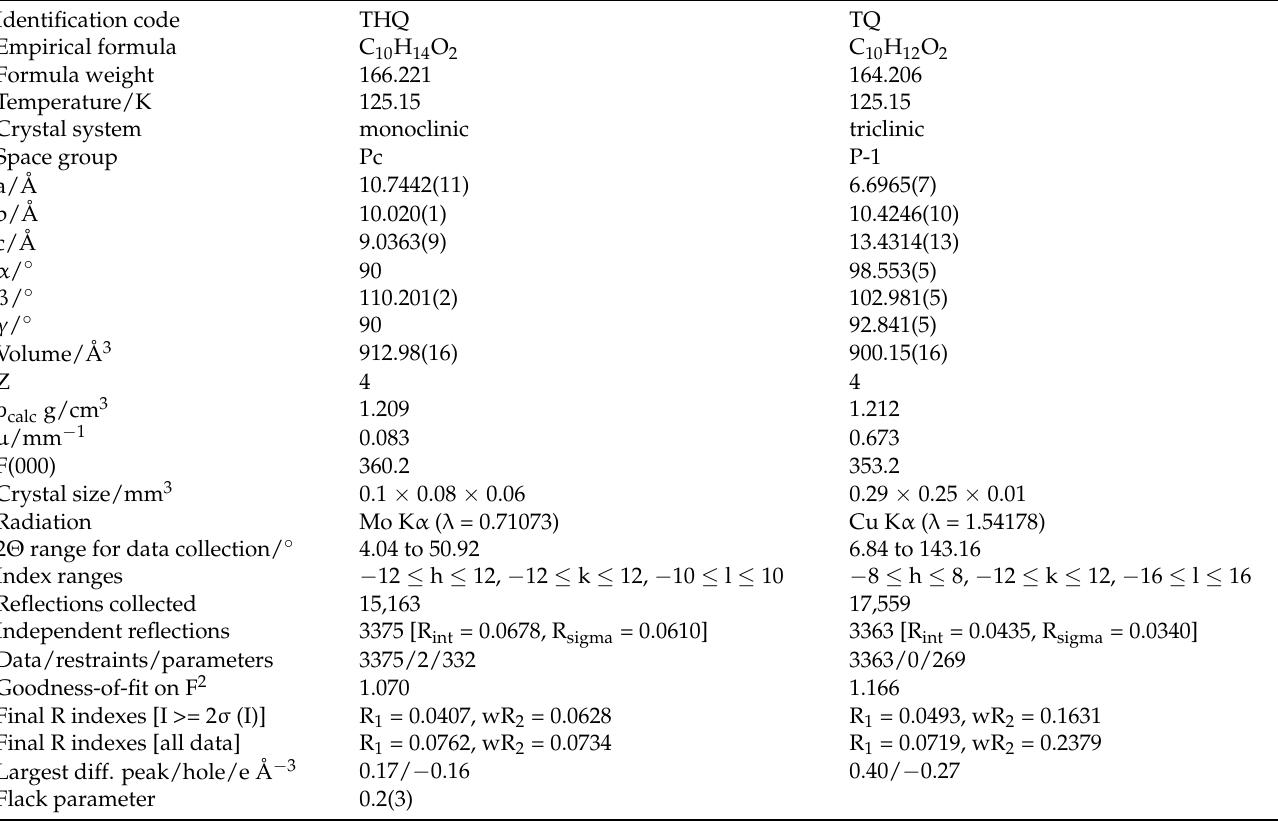
Table 1. Crystal data and structure refinement for thymohydroquinone (THQ), thymoquinone